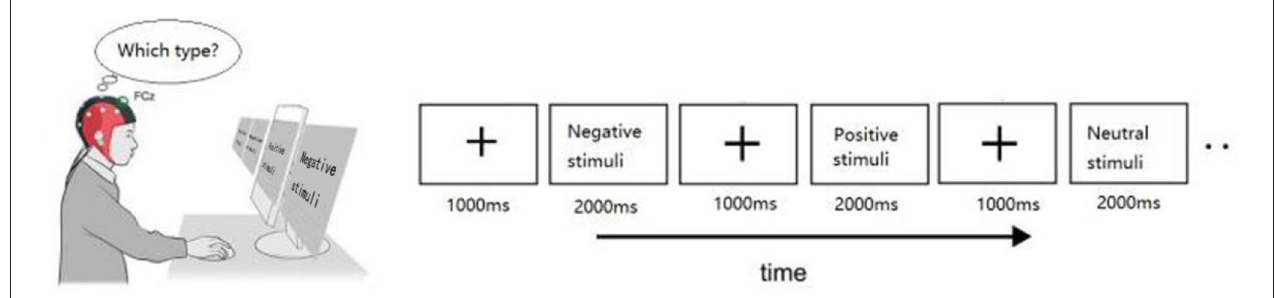
FIGURE 1 | Illustration of the stimulus paradigm